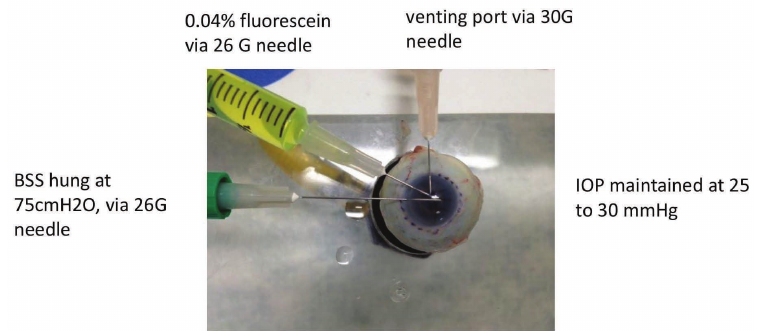
Figure 2. Eye perfusion system. Balanced salt solution (BSS) solution was delivered into the eye via a 26-gauge needle. Intraocular pressure (IOP) was maintained at between 25 and 30 mmHg. A smaller caliber 30-gauge needle was used to create a venting port at 90 o away from the infusion port. A 26-gauge needle was inserted half-way between the infusion and venting ports to inject